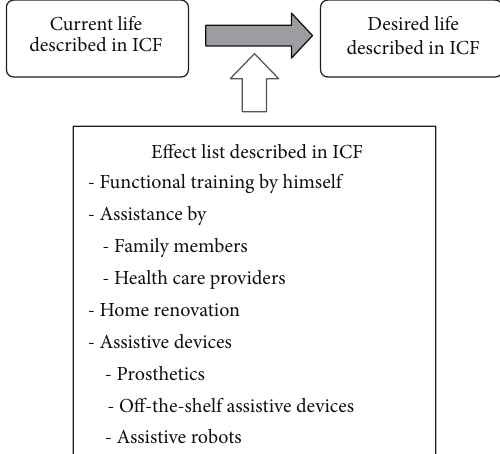
Figure 3: Concept of life design based on ICF